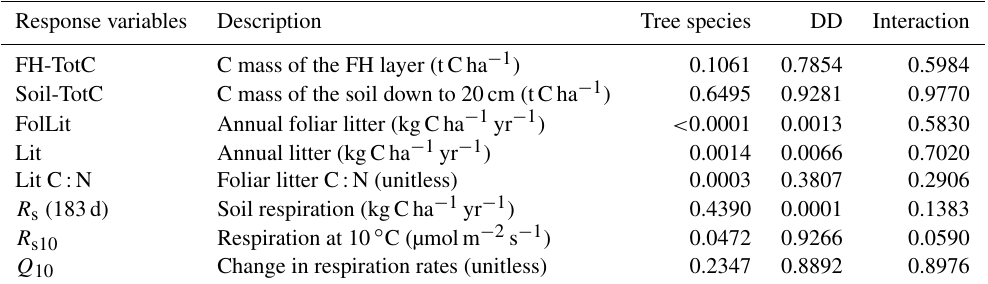
Table 3. Results of statistical analyses ( p values) from a GLM testing for forest type (tree species), degree-days (DD) and their interaction for C fluxes, soil C pools and estimated parameters from the in situ soil respiration–soil temperature